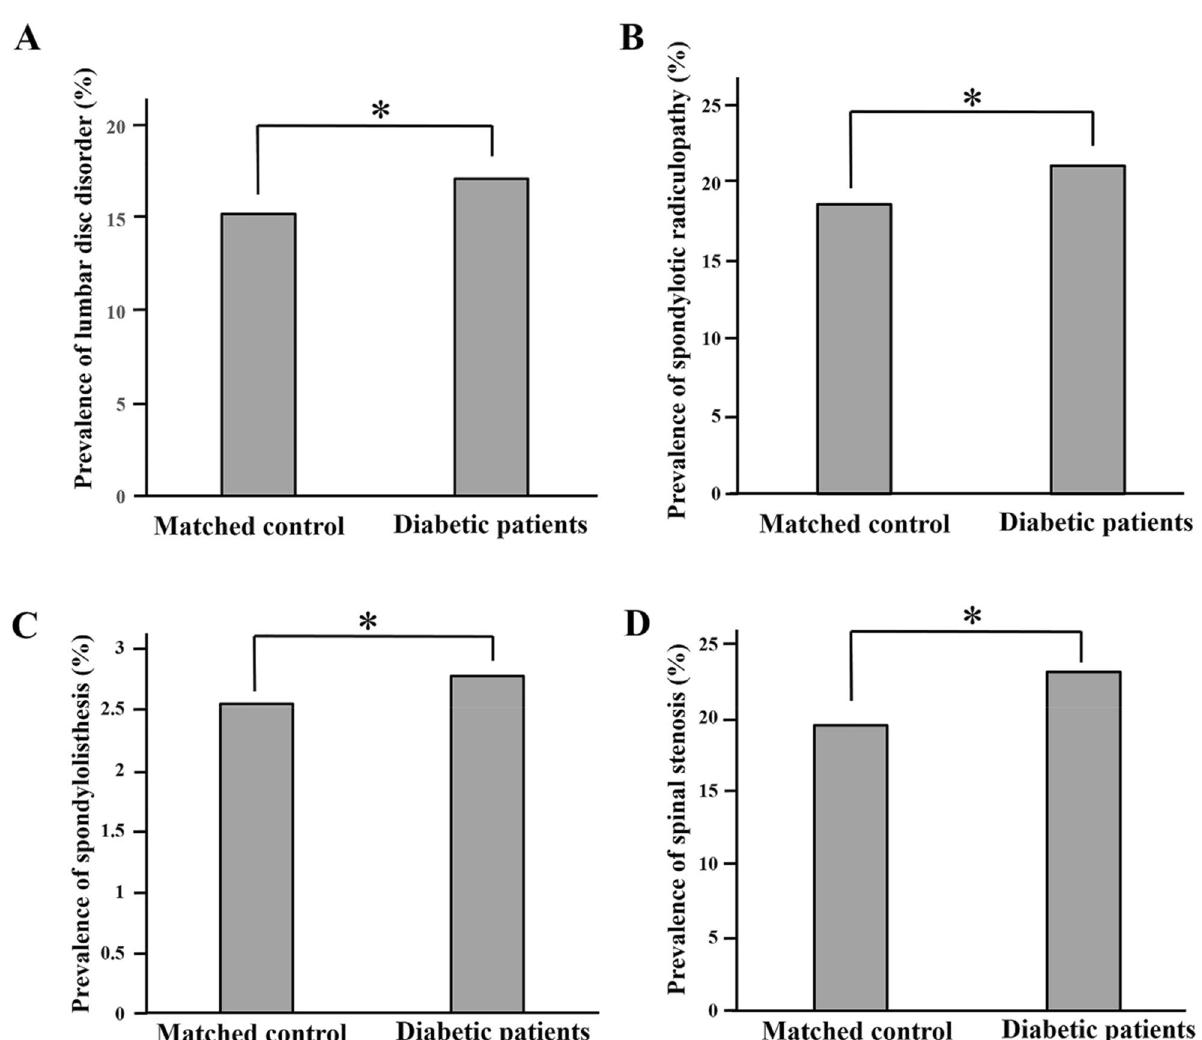
Figure 2. Prevalence of ( A ) lumbar disc disorder, ( B ) spondylotic radiculopathy, ( C ) spondylolisthesis, ( D ) spinal stenosis in matched control and diabetic patients. * p <